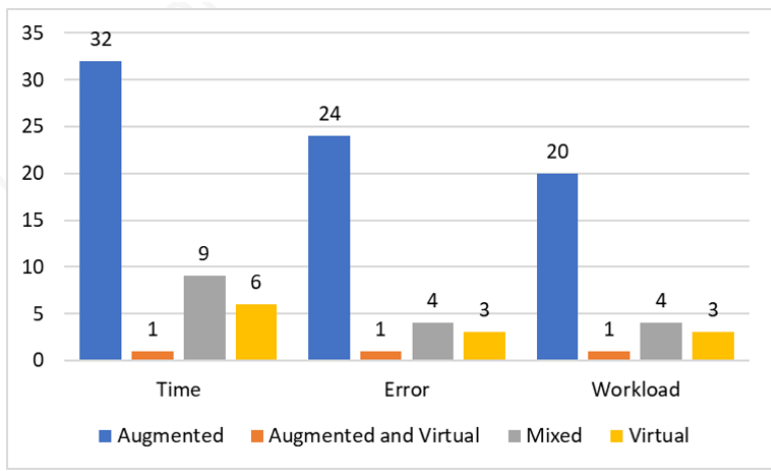
Figure 7. Worker’s performance analyzed for augmented, virtual and mixed reality